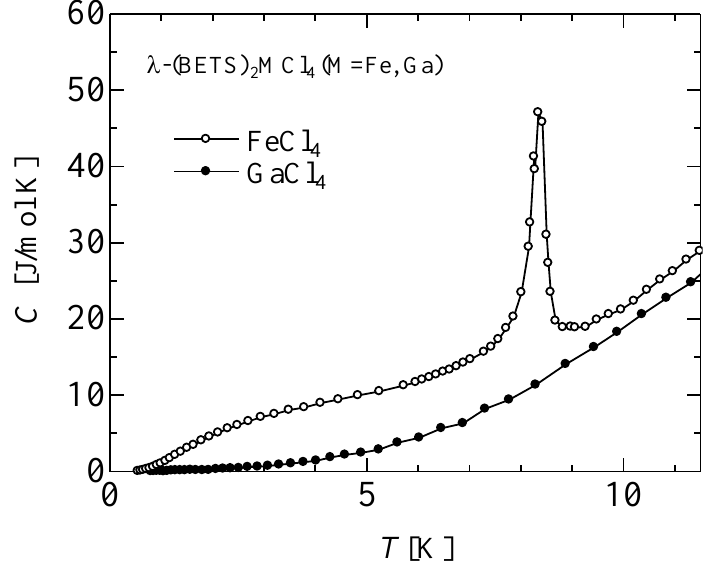
Figure 1. Temperature dependencies of the specific heat of λ-BETS λ-BETS GaCl (●). Reproduced with permission from JPSJ [11]. 2 4